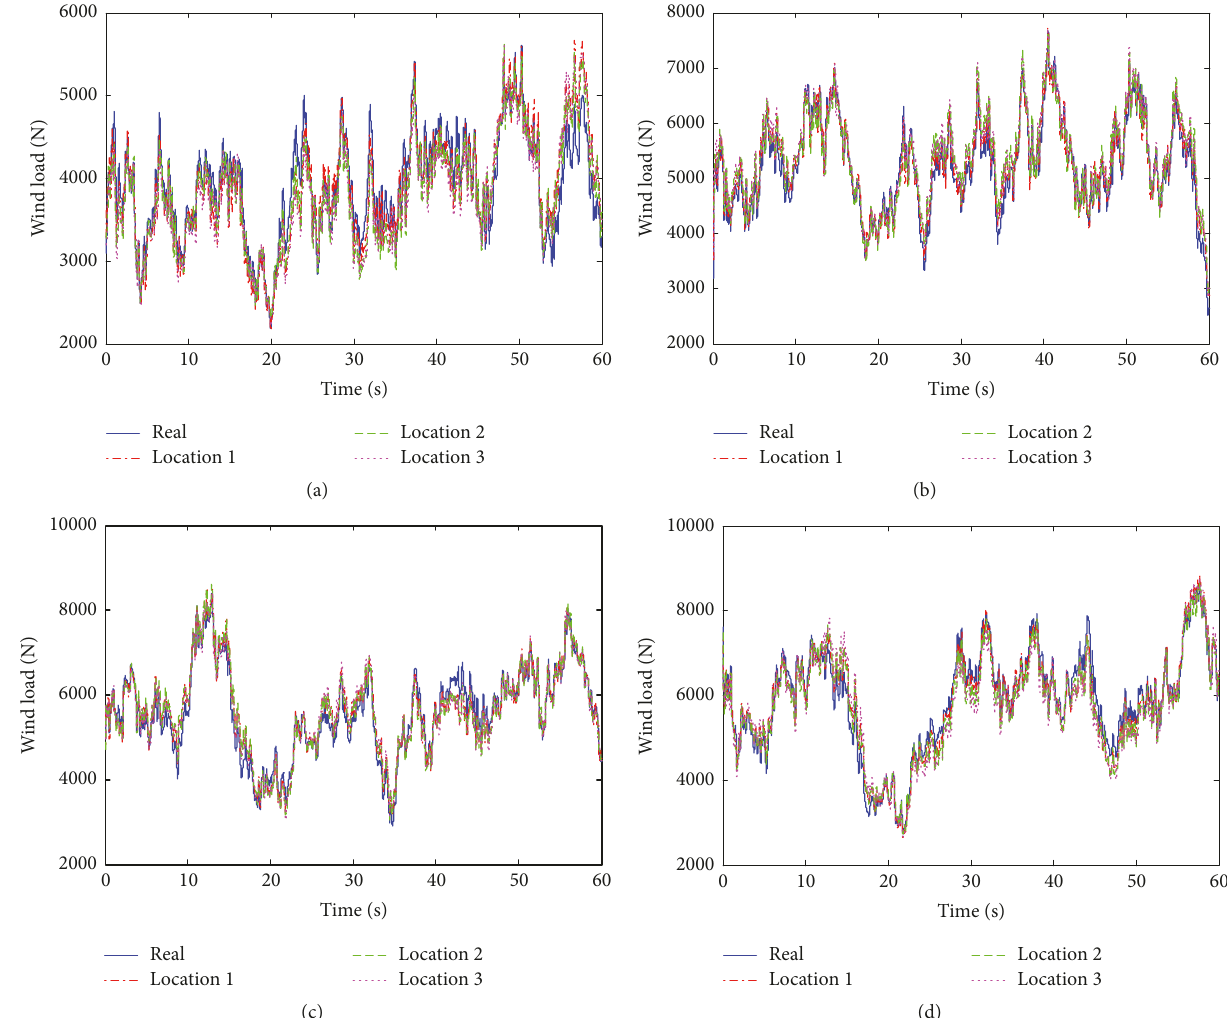
Figure 7: The time histories of the estimated wind load for different types of sensor location. (a) On the 5th floor; (b) on the 10th floor; (c) on the 15th floor; (d) on the 20th